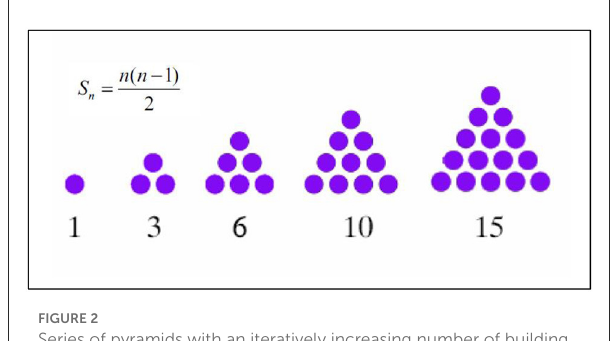
FIGURE2 Series of pyramids with an iteratively increasing number of building blocks.